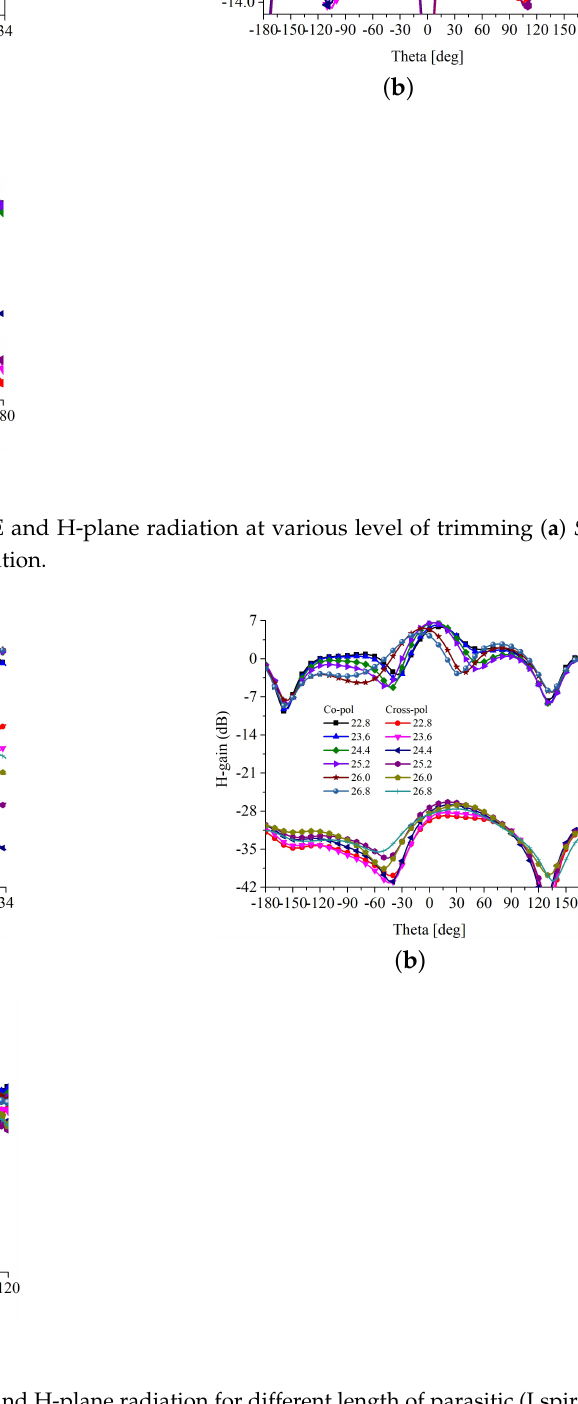
Figure 5. Impedance matching and E and H-plane radiation for different length of parasitic